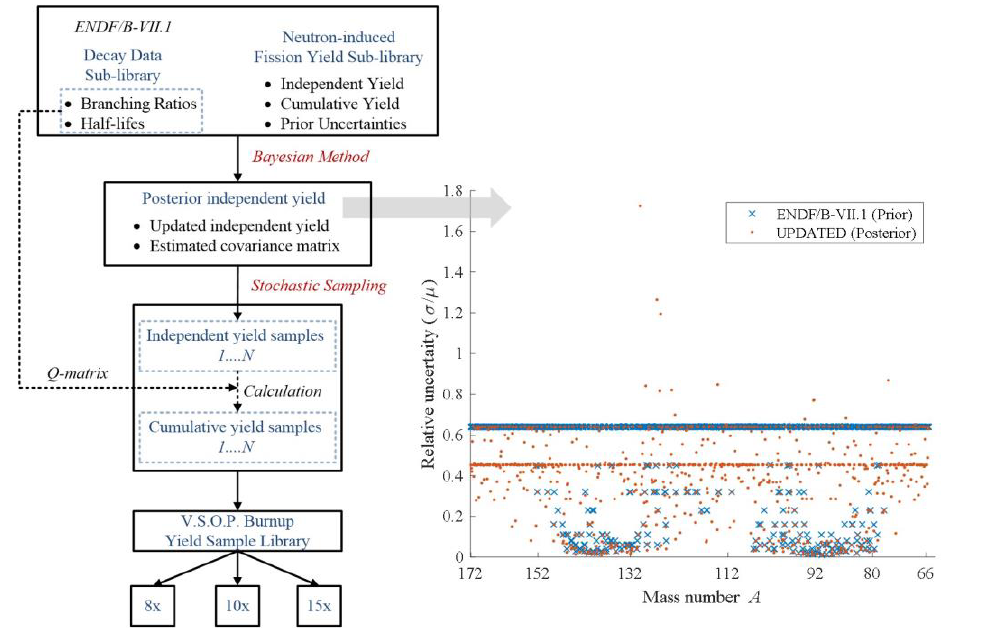
Figure 3. Fission product yield uncertainty propagation flowchart (Left) and relative uncertainty of prior and posterior independent yields (Right). Several larger posterior relative uncertainty (larger than 60%) result from large discrepancy between calculated prior cumulative yields and those provided in ENDF/B-VII.1.